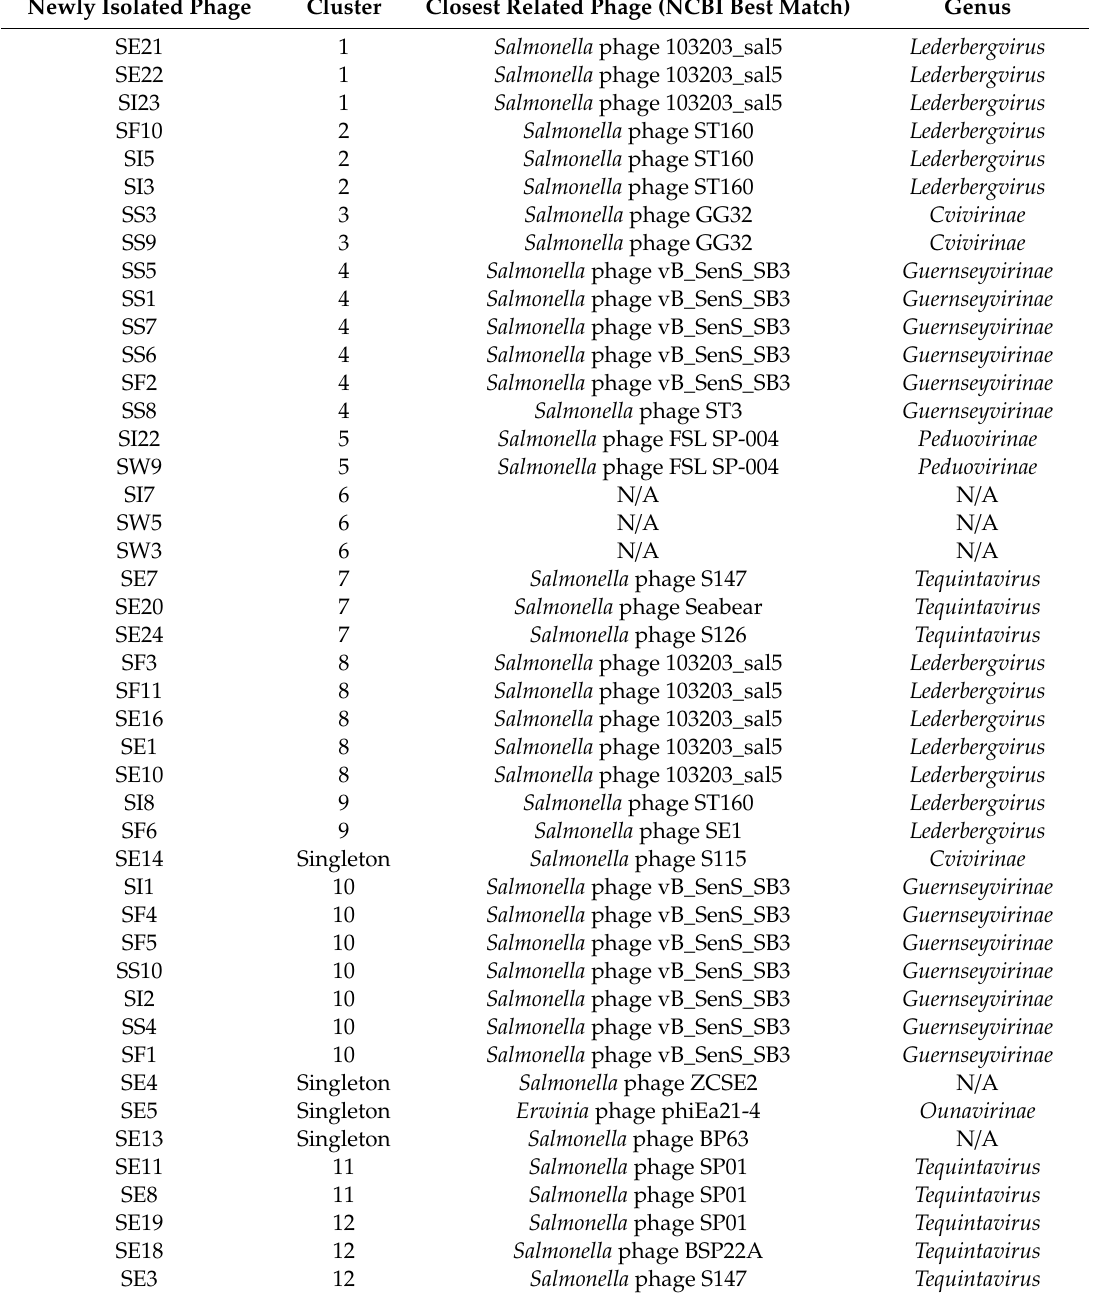
Table 1. Closest related sequenced phages to newly isolated phages. The closest related phages (possessing highest E-value and > 50% query coverage) and their respective genera were determined through nucleotide homology using NCBI